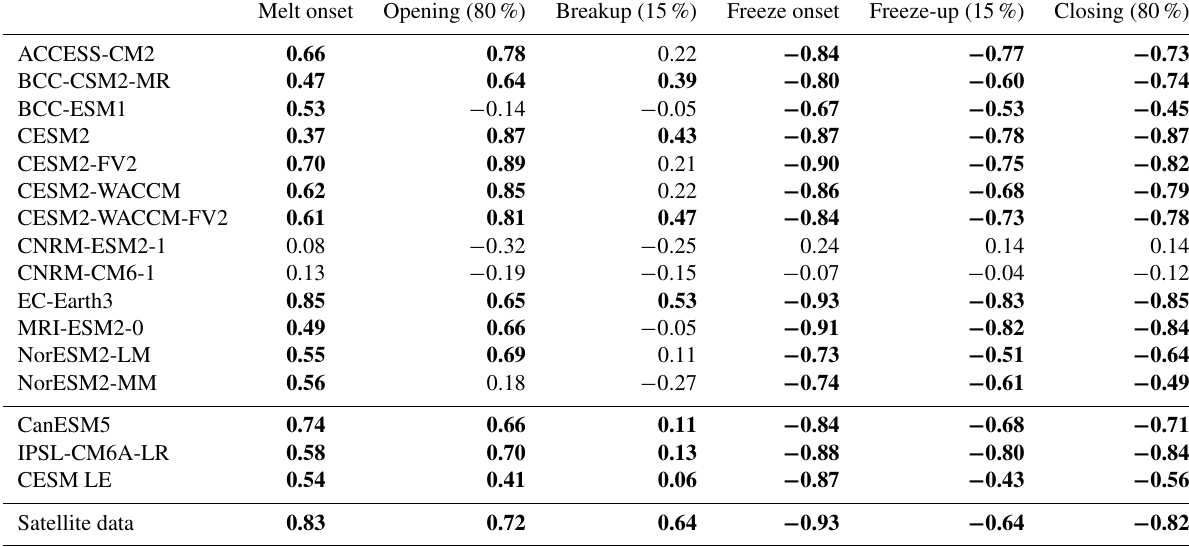
Table 6. Correlation coefficients ( R values) between seasonal sea ice transition dates and mean summer (June–September) sea ice area of the same year from 1979 to 2014. Values in bold are statistically significant at the 95% confidence level. Correlation coefficients and p values for models in the first 13 rows are determined using 1 ensemble member, for CanESM5 using all 35 ensemble members, for IPSL using all 30 ensemble members, and for CESM LE using all 40 ensemble members. All values are calculated between 66 and 84.5 ◦ N.